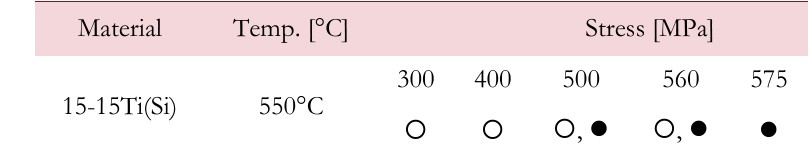
Table 2: Matrix of the main